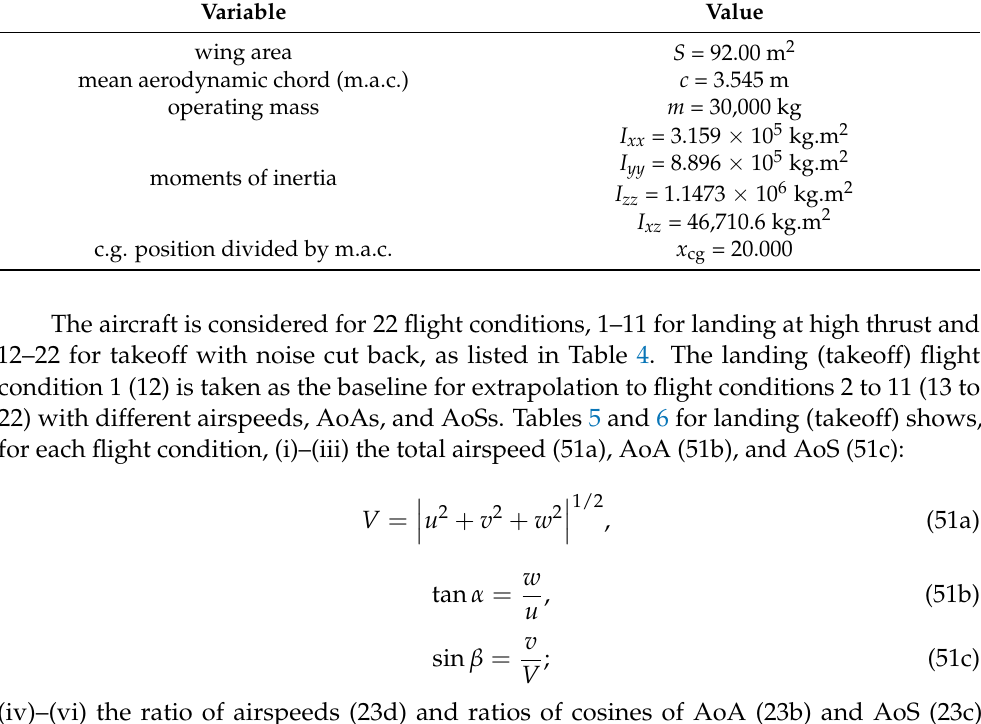
Figure 1. V-tailed single-aisle jet airliner. Table 3. V-tailed jet airliner basic data.